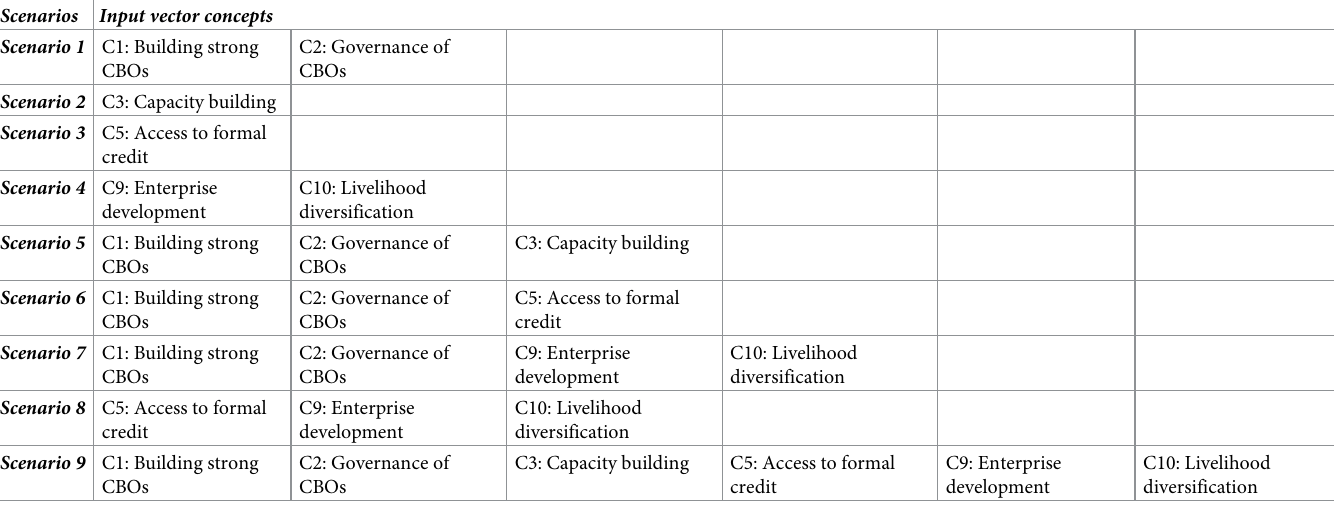
Table 1. The input vector concepts of each scenario. Scenarios Input vector